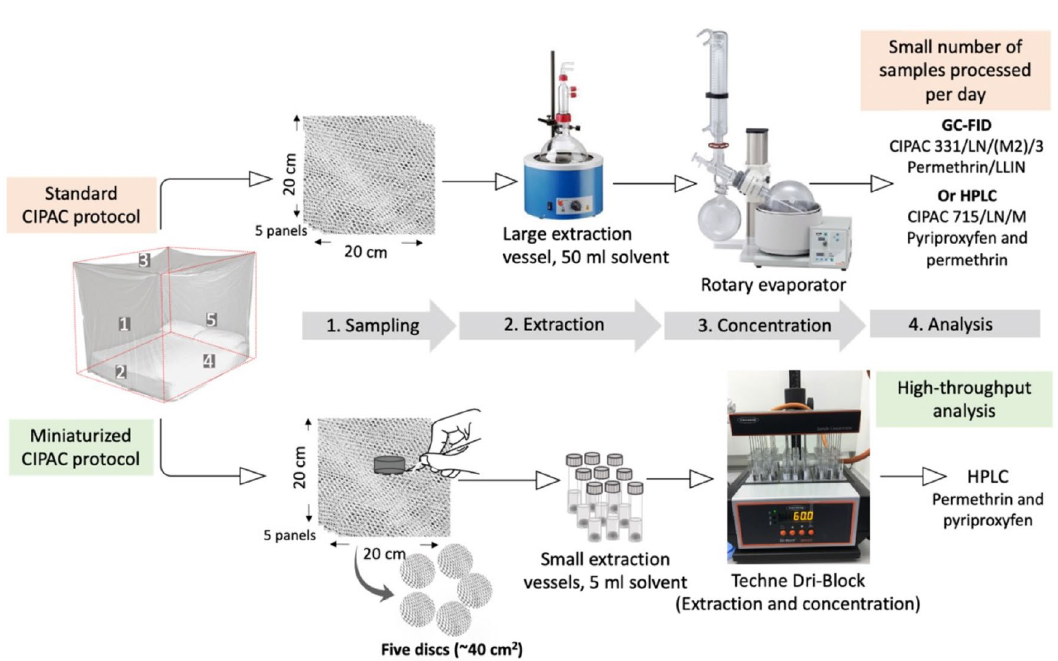
Figure 2. Comparison of standard CIPAC method with a miniaturised protocol for determining insecticide content incorporated in long-lasting bed nets (LLINs). The sample size has been reduced from 400 cm 2 (2 g) to ~ 40 cm 2 (0.2 g) to enable a small volume of extraction solution (5 vs. 50 used in the standard CIPAC methods) for permethrin 12 and pyriproxyfen 13